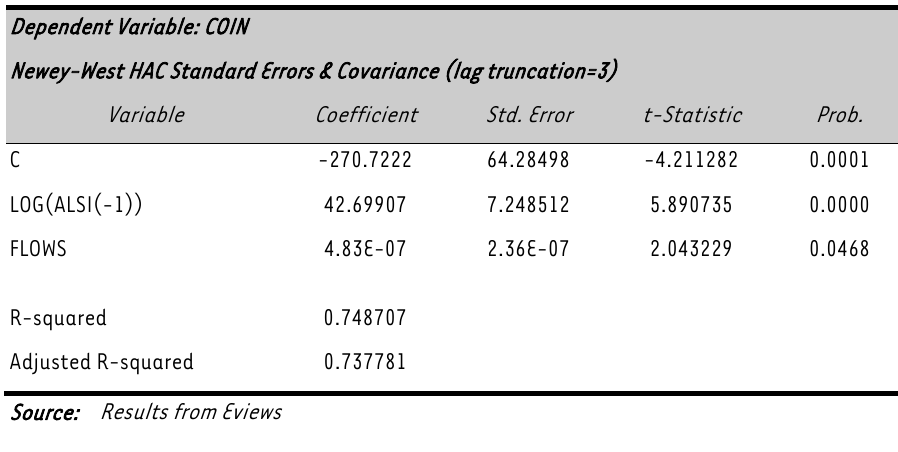
FIGURE 1: Equity component of the financial